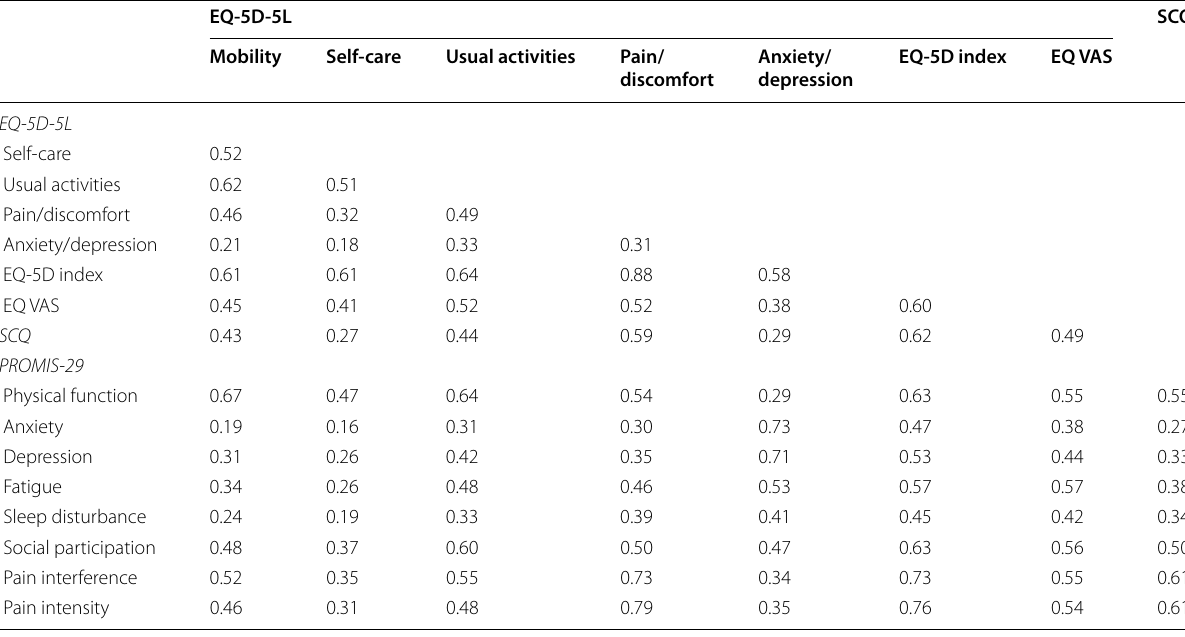
Table 4 Spearman correlation coefficients between PROMIS-29, EQ-5D-5L and SCQ scores (n